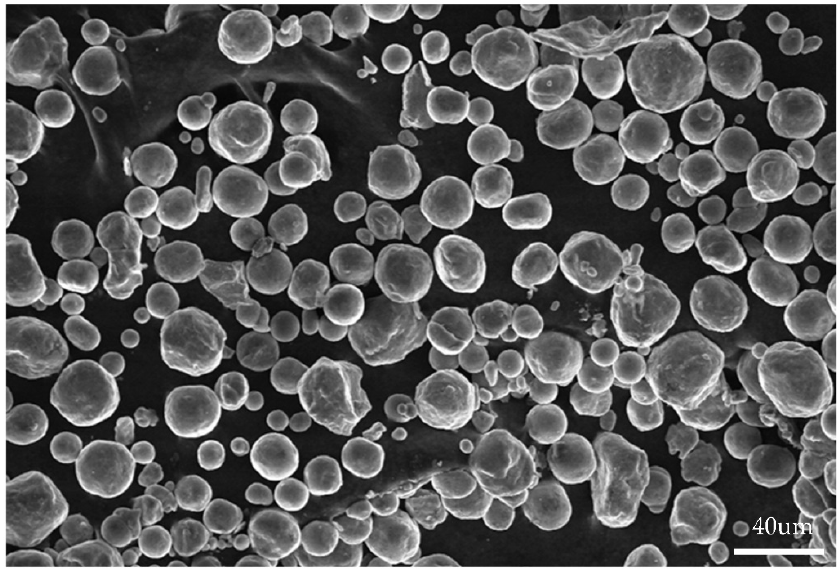
Figure 4 . Homogeneous mixture of powders . Figure 4. Homogeneous mixture of powders.